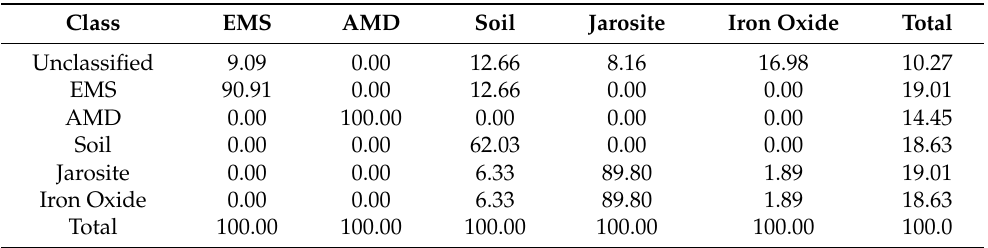
Table A6. March 2019 maximum likelihood. Overall accuracy points: 214/243, overall accuracy: 81%, kappa coefficient: 0.7723.